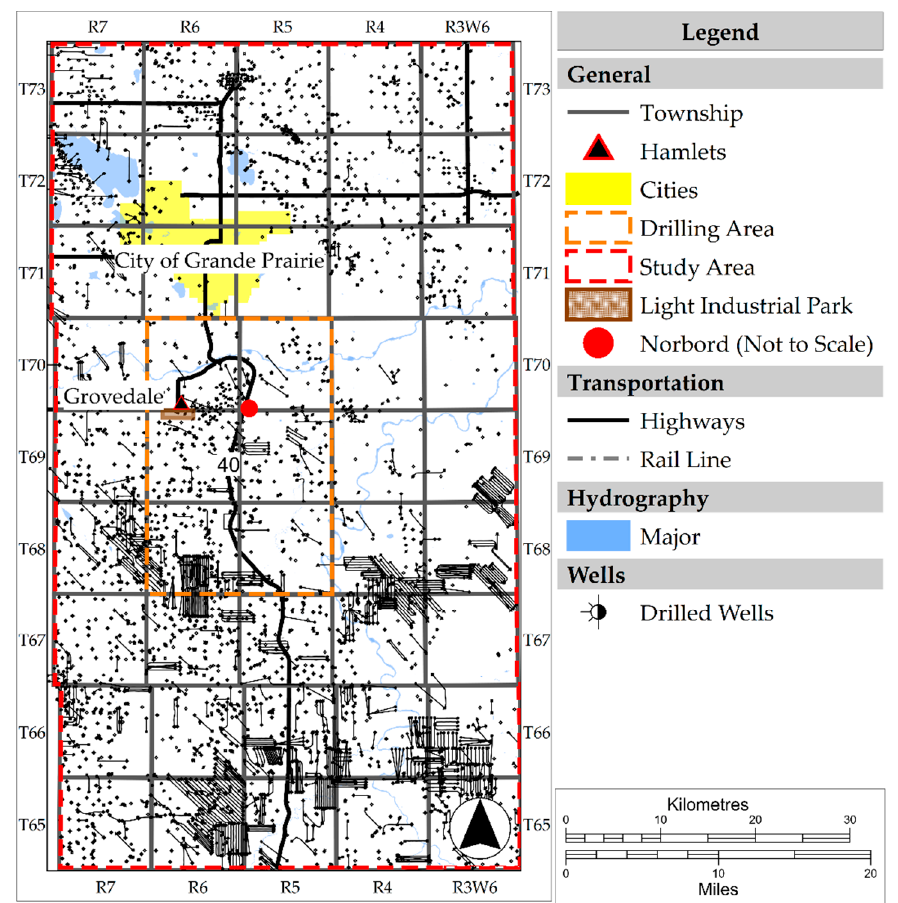
Figure 2. The wells previously drilled shown within the study area and the drilling area where Alberta No. 1 plans to drill production and injection wells. The areas encompass a planned light industrial park and the Norbord OSB facility.